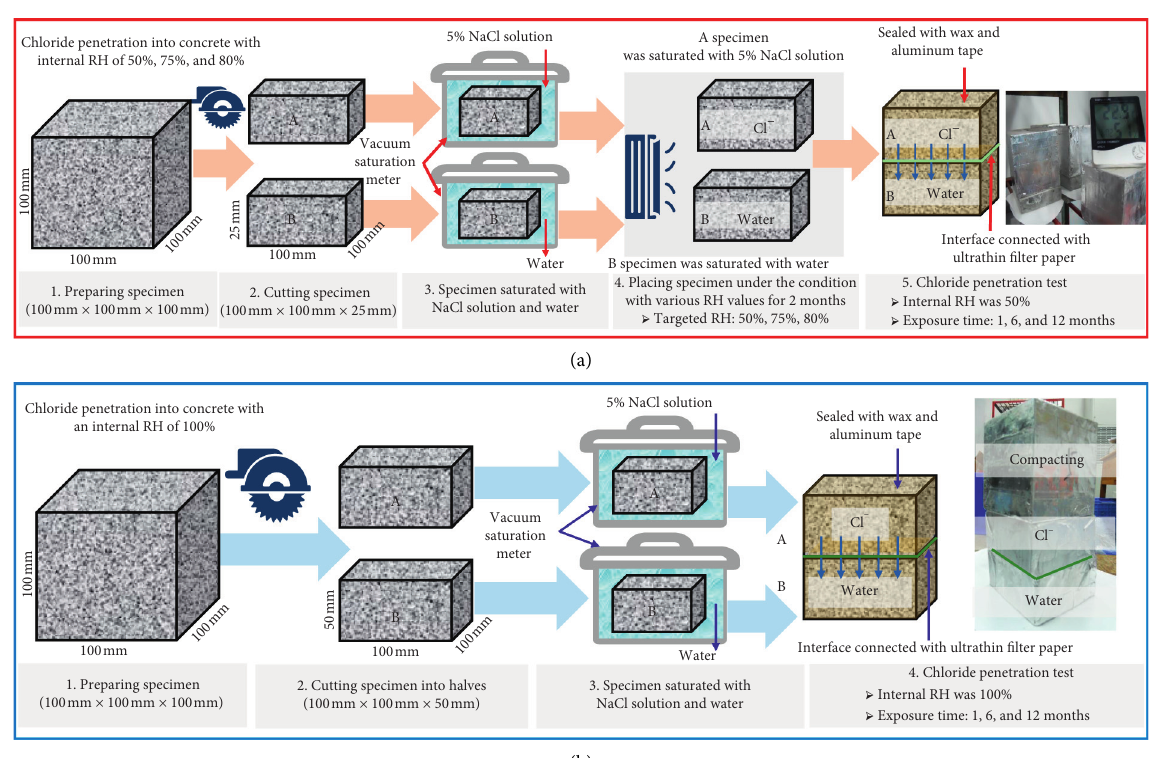
Figure 1: Experiment flow for the chloride migration into concrete with various internal RH values. (a) When internal RH of concrete was 50%, 75%, and 80%. (b) When internal RH of concrete was